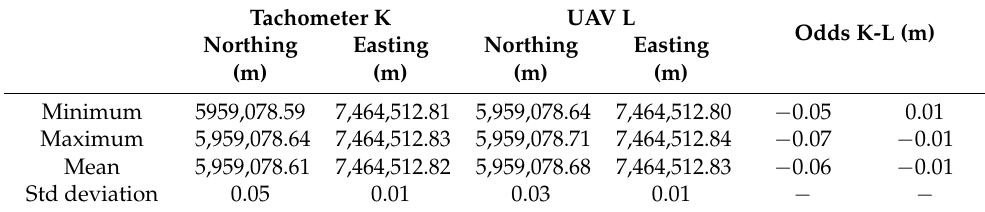
Table 2. Statistics for measured coordinates (altitude H = 5 m).